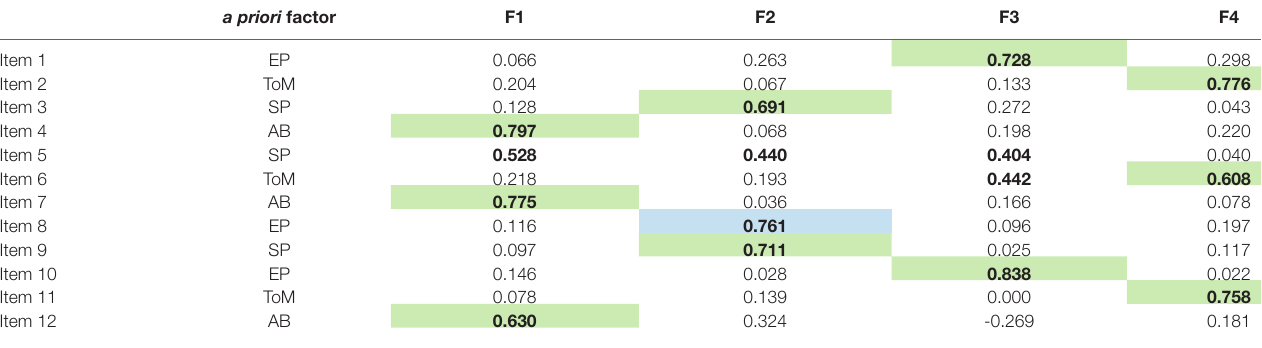
TABle 3 | Factor loadings of the 12 items of the ACSo. The four a priori components of the scale are: Emotional Processes (EP), Theory of Mind (ToM), Attributional Biases (AB) and Social Perception and knowledge (SP). Items were included in the factor structure if they loaded |0.40| or higher on a factor (written in bold), and if the loading was at least |0.10| higher than the loading on any other factor. Loadings are highlighted in green when they agree with the a priori structure or in blue when they belong to another